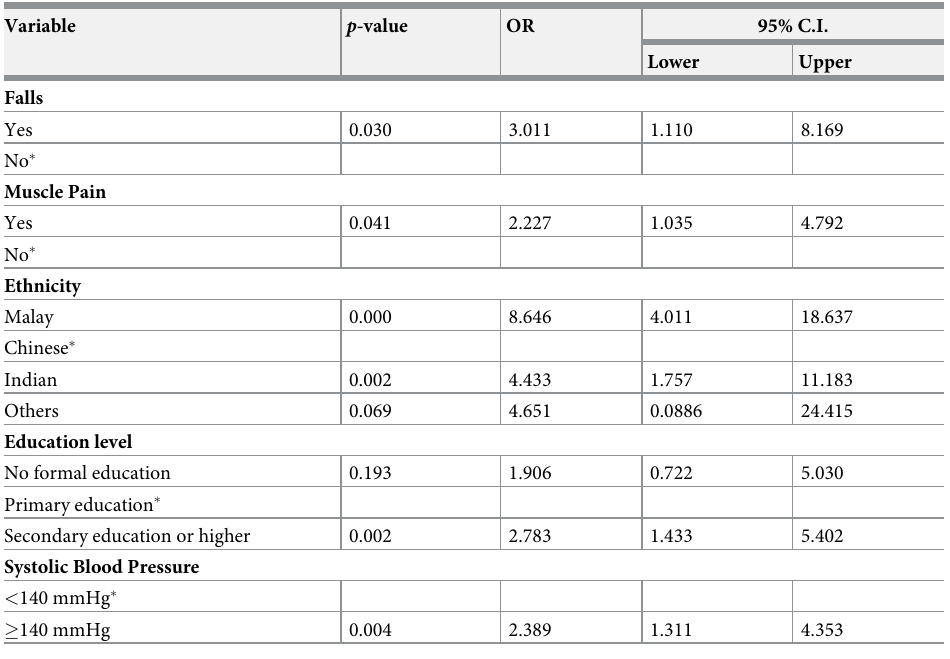
Table 3. Predictors of crude herbs use. Variable p -value OR 95%